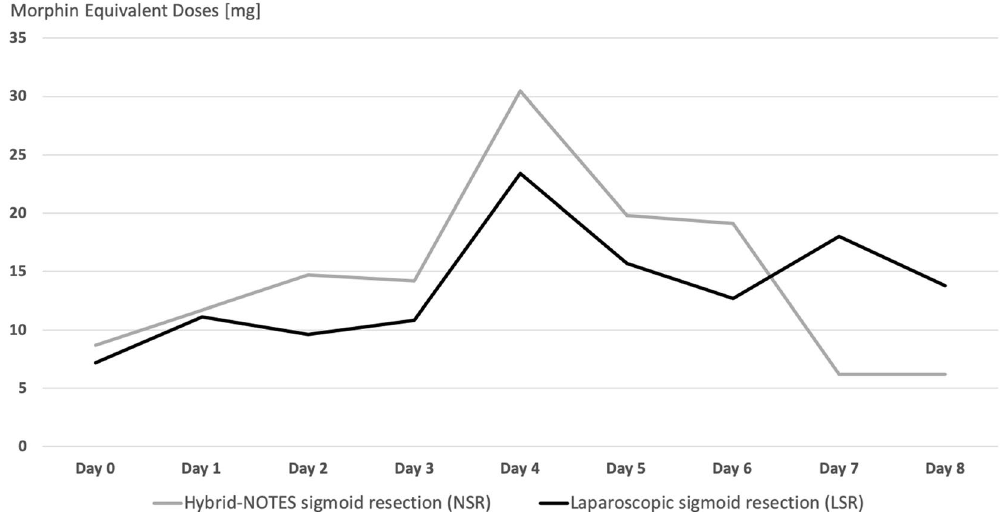
Figure 5. Morphine equivalent doses over time.